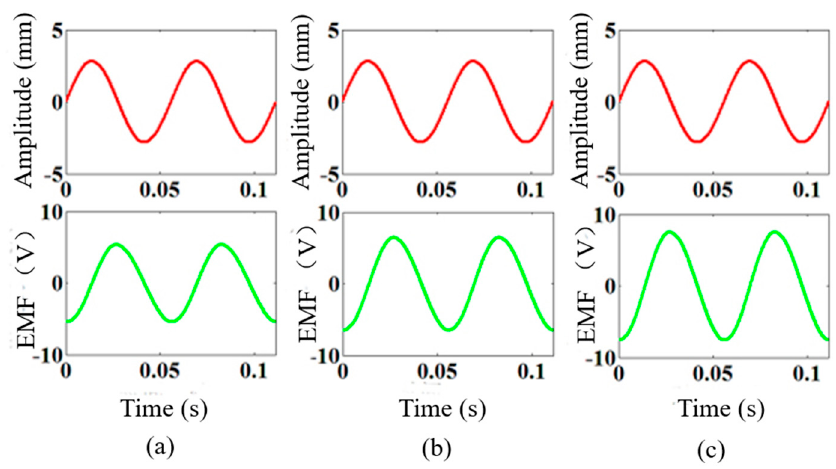
Figure 10. Effect of the number of coil turns on the EMF: ( a ) 188; ( b ) 1130; ( c ) 1319.